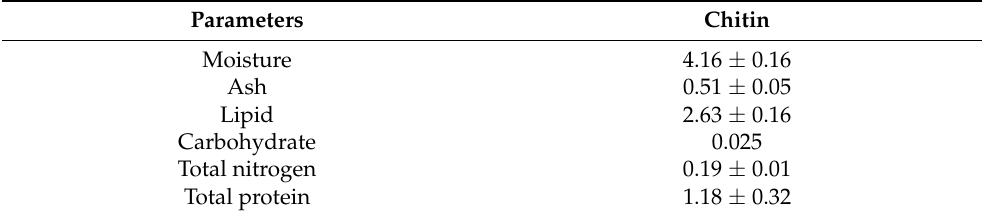
Table 1. Biochemical composition of chitin extracted from Parapenaeus longirostris caught from the north of Tunisia. Values (g/100 g) are reported as dry mass ( n = 3 in each analysis, ± : Standard Error).